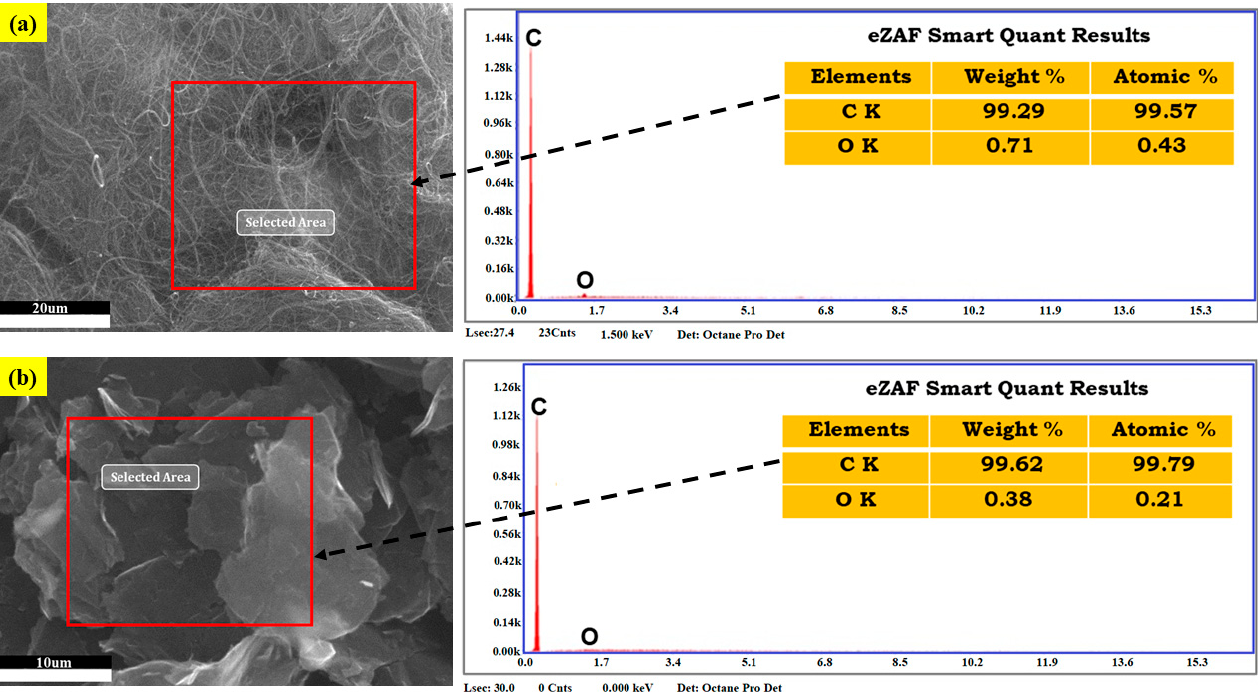
Figure 2. EDS analysis of reinforcement materials: ( a ) MWCNT Nano-powder and ( b ) Graphene Nano-powder in pristine state.